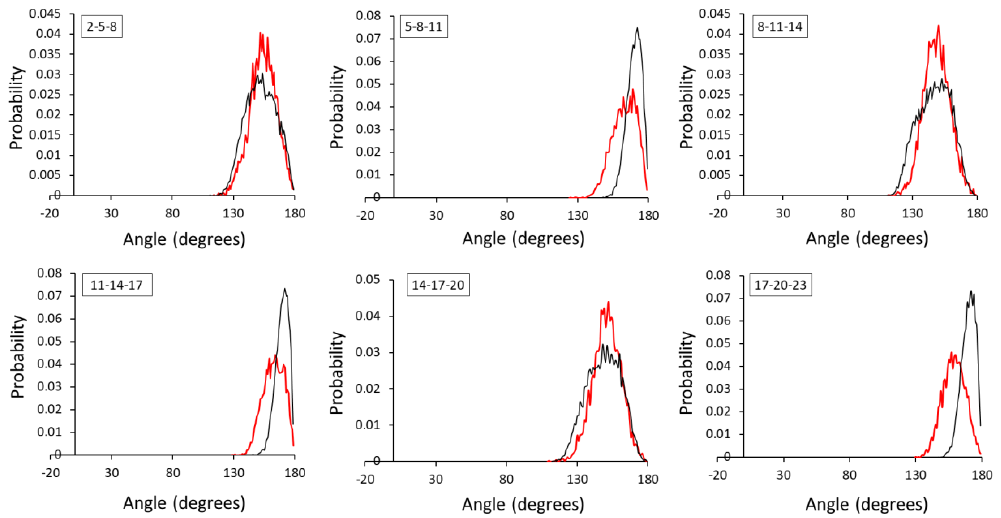
Figure 6. Main chain angle distributions of AA and CG representations for an HA octasaccharide molecule. Black and red lines indicate AA and CG representations, respectively.